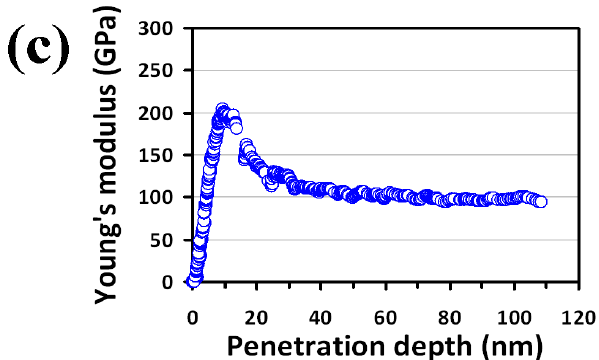
Figure 1. Nanoindentation results of single-crystal InP(100): ( a ) load-displacement curve showing the multiple “pop-ins” (arrows) during loading, ( b ) hardness-displacement curve and, ( c ) Young’s modulus-displacement curve.